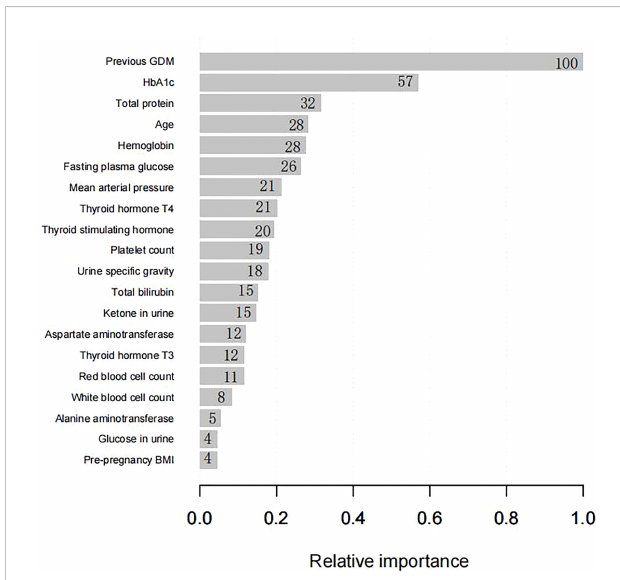
FIGURE 1 The relative importance of the 20 variables included in the XG Boost ML model for GDM in the training set. BMI, body mass index; GDM, gestational diabetes mellitus; HbA 1c , glycated hemoglobin; XG Boost ML, extreme gradient boosting (XG) machine learning (ML).